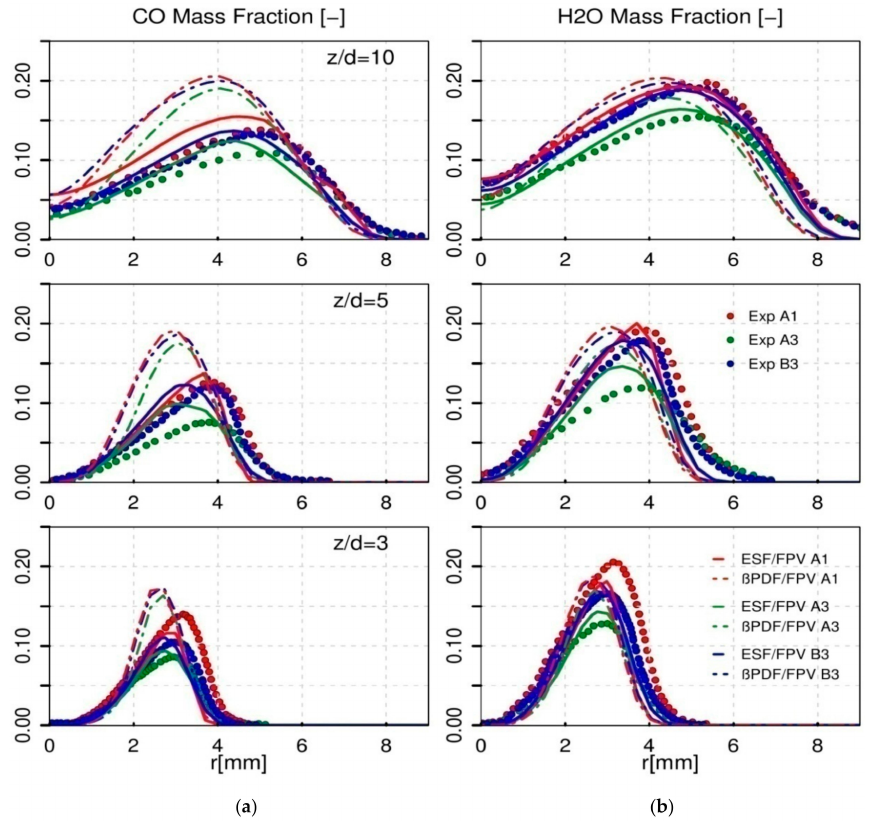
Figure 11. Mean CO ( a ) and H 2 O ( b ) mass fraction from ESF/FPV simulation with 48 SFi at different axial positions for flame cases A1, A3 and B3 in comparison with β -PDF results and Raman/Rayleigh data from